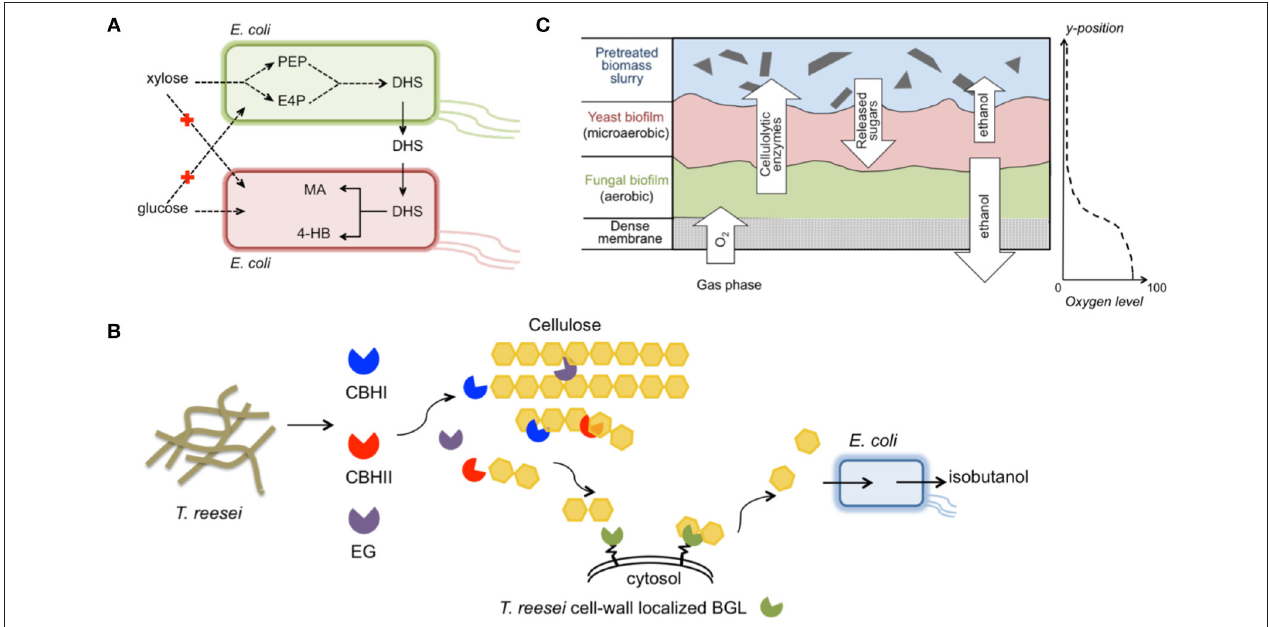
FIGURE 5 | Exemplary engineered microbial consortia. (A) An E. coli / E. coli consortium for improved production of MA and 4HB from a glucose/xylose mixture (Zhang et al., 2015); (B) A T. reesei / E. coli consortium for direct conversion of biomass hydrolysates to isobutanol (Minty et al., 2013); (C) A T. reesei / S. cerevisiae / S. stipitis biofilm membrane reactor integrating aerobic cellulolytic enzyme production and anaerobic ethanol accumulation (Brethauer and Studer, 2014). The images were prepared according to the previous individual studies. Abbreviation of metabolites— PEP, phosphoenolpyruvate; E4P, erythrose-4-phosphate; DHS, dehydroshikimate; MA, cis, cis -muconic acid; 4-HB, 4-hydroxybenzoic acid; CBHI, cellobiohydrolase I; CBHII, cellobiohydrolase II; EG, endoglucanase; BGL, β